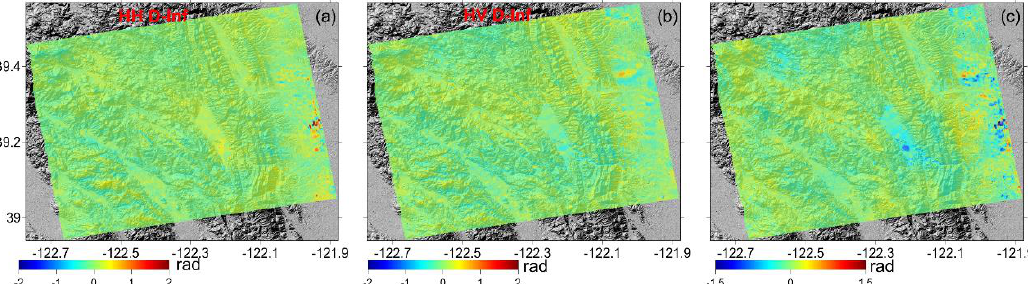
Figure 6. ( a ) HH and ( b ) HV D-Infs corrected by the MRWCA method. ( c ) The difference map between the corrected HV and HH D-Infs.